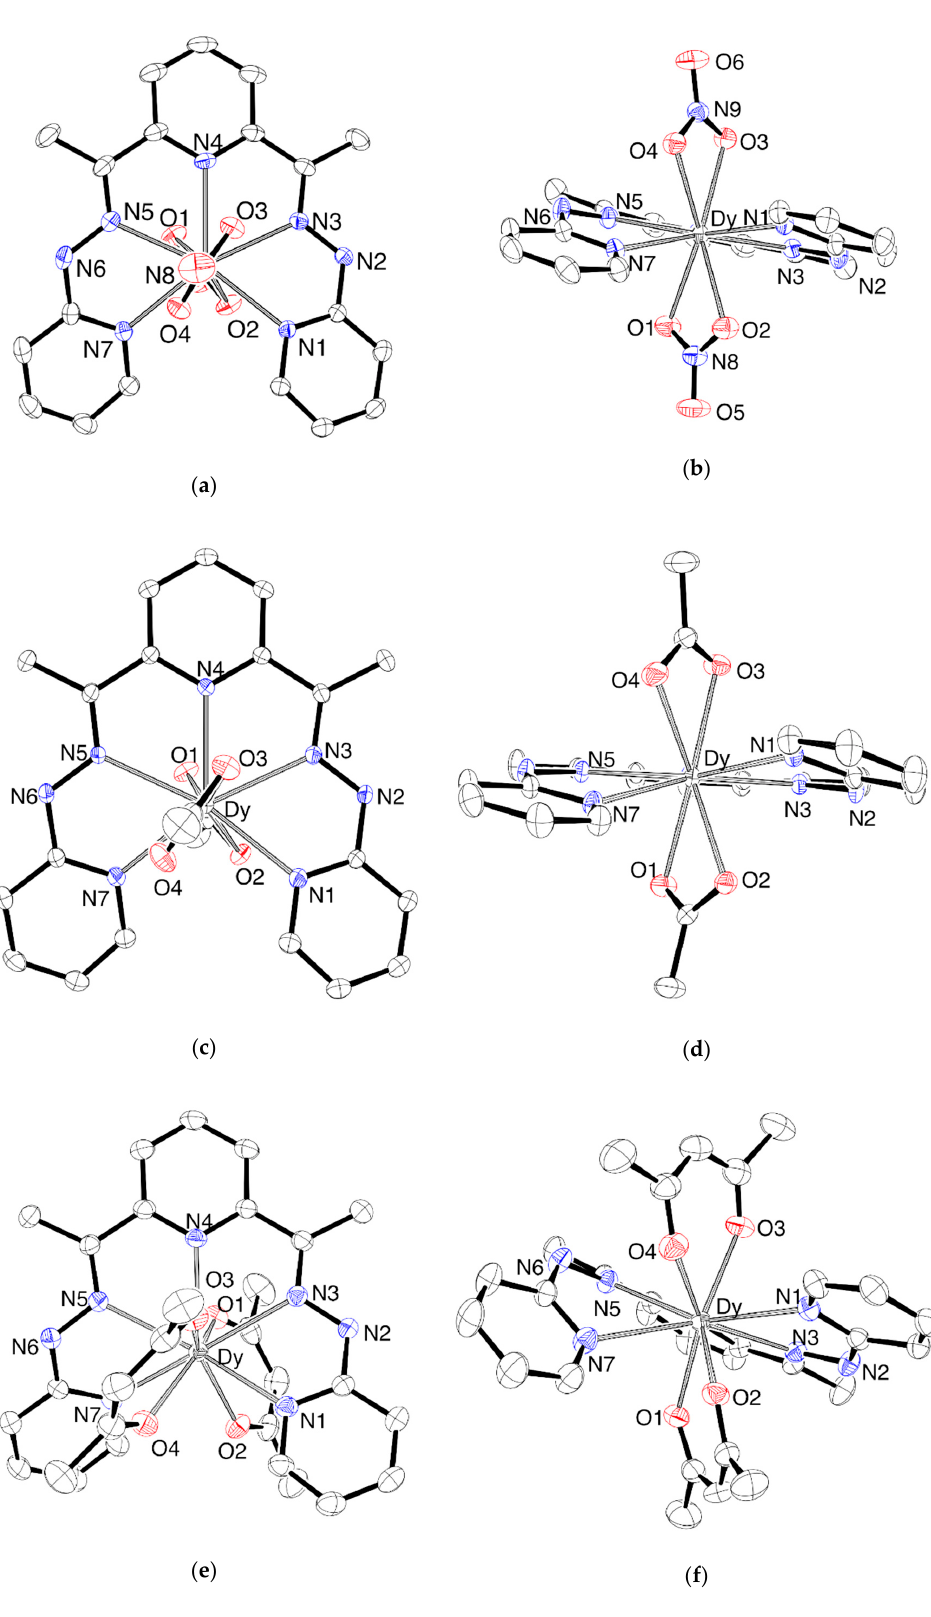
Figure 2. ORTEP drawing of the cationic parts of 1 ( top ), 2 ( central ), and 3 ( bottom ) at the 50% probability level. Hydrogen atoms are omitted for clarity: ( a , c , e ) Top view and ( b , d , f ) side view of the